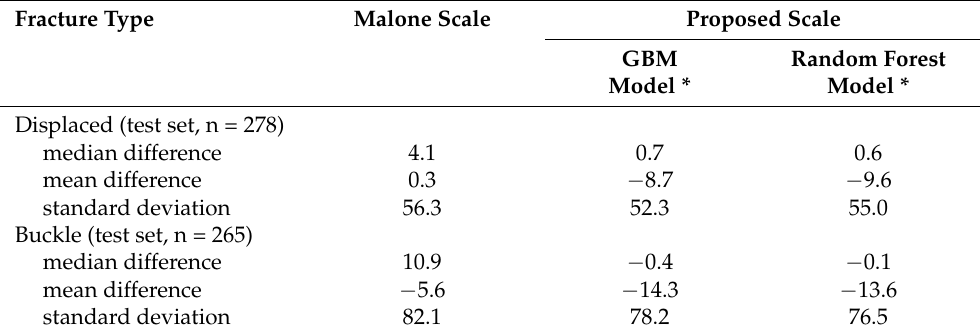
Table 4. Performance of three models: (predicted fracture age) − (true fracture age),